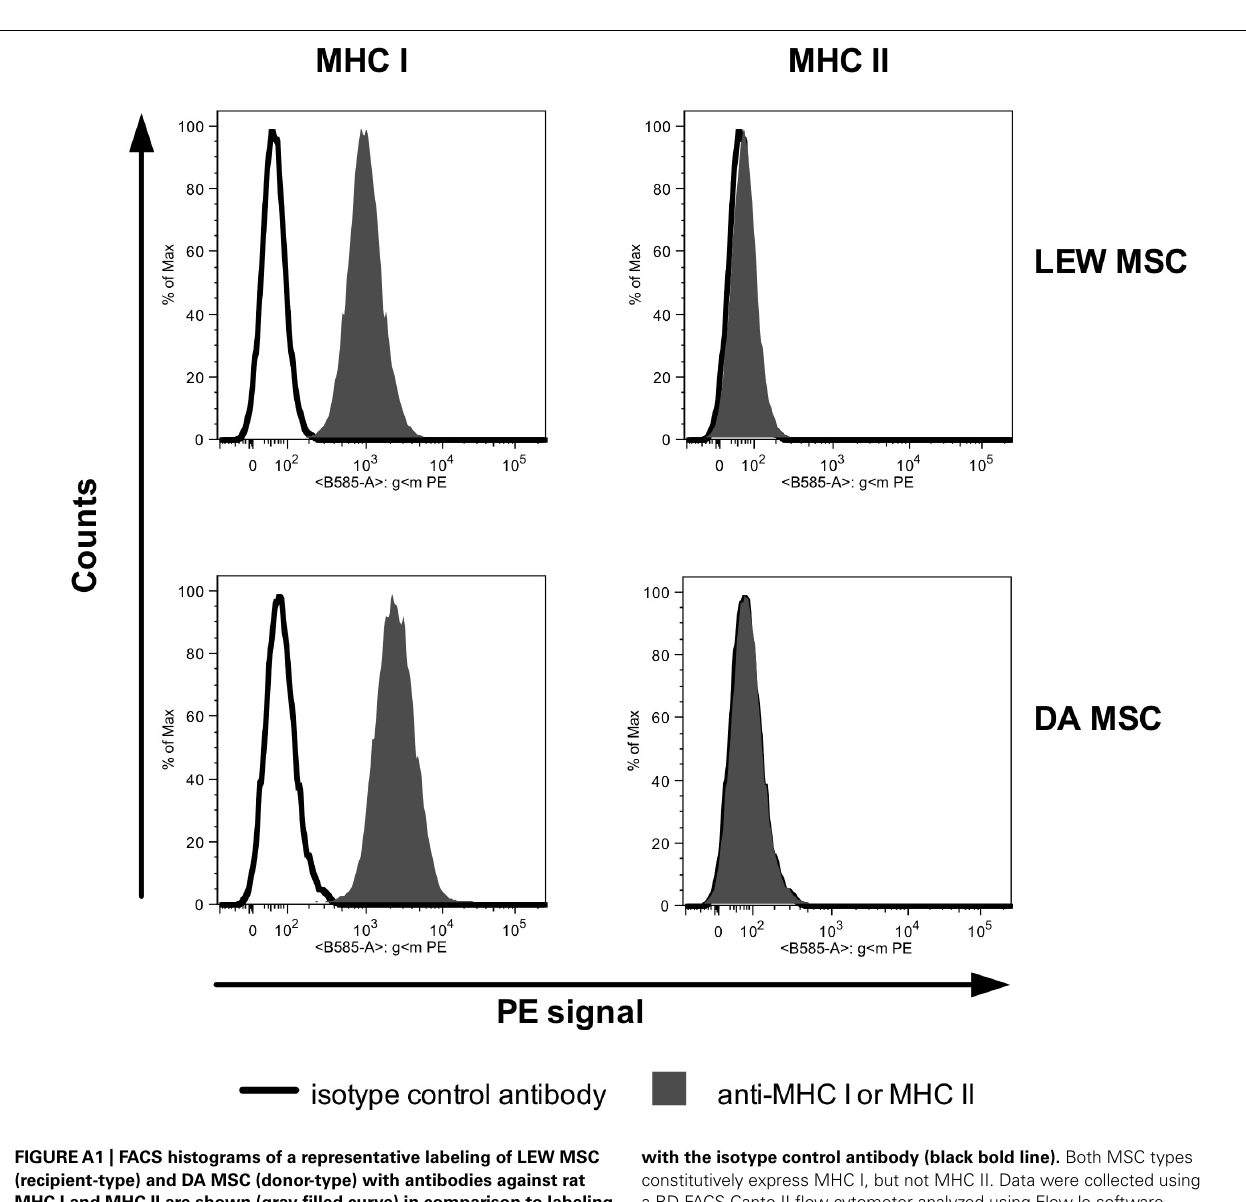
FIGUREA1 | FACS histograms of a representative labeling of LEW MSC (recipient-type) and DA MSC (donor-type) with antibodies against rat MHC I and MHC II are shown (gray filled curve) in comparison to labeling